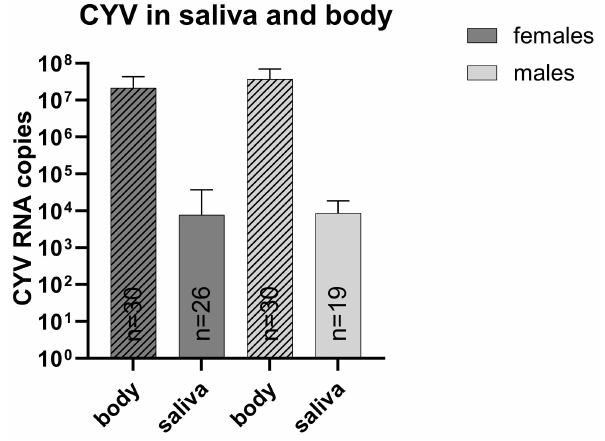
Figure 3. CYV measurement in saliva and carcasses five days after injection in Cx. pipiens biotype molestus mosquitoes after forced salivation. Shown are mean viral RNA copies measured by qRT-PCR per mosquito displayed with SD. Dark grey with lines—female bodies (n = 30); dark grey—female saliva (n = 26); light grey with lines—male bodies (n = 30); light grey—male saliva (n = 19).